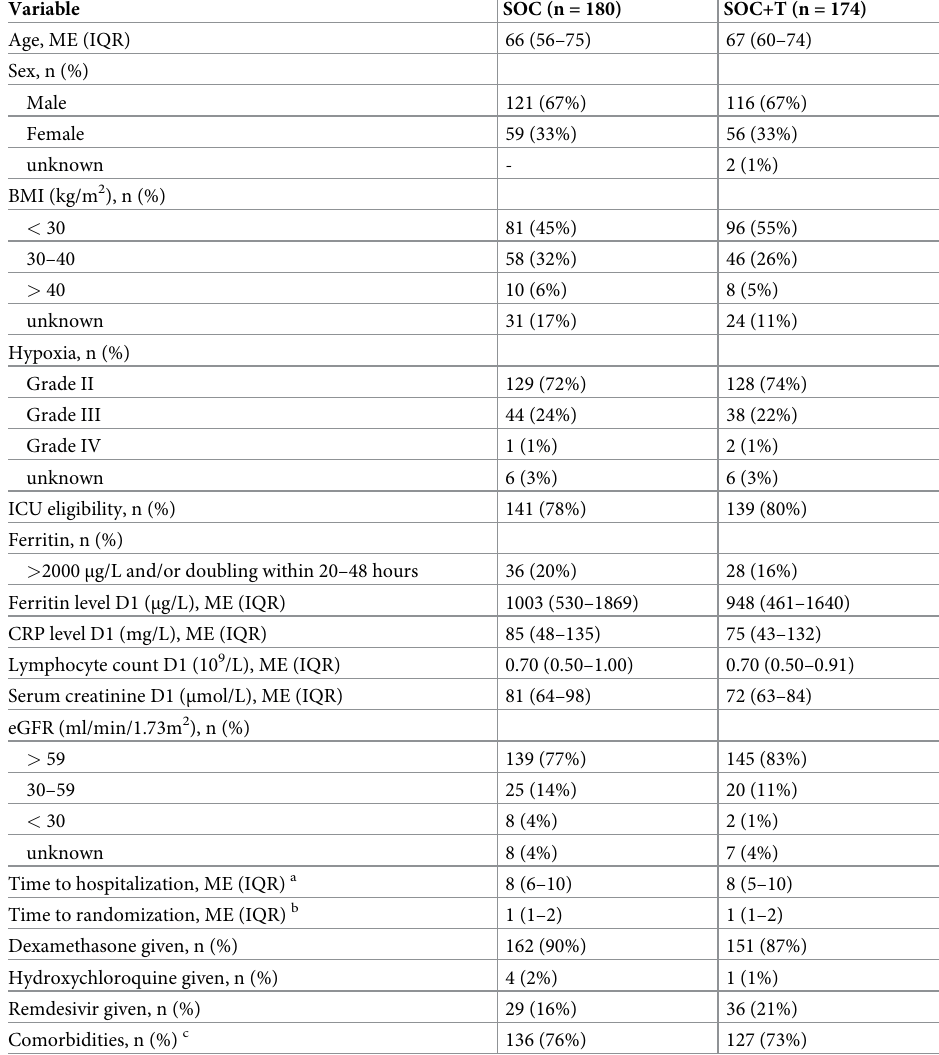
Table 1. Baseline